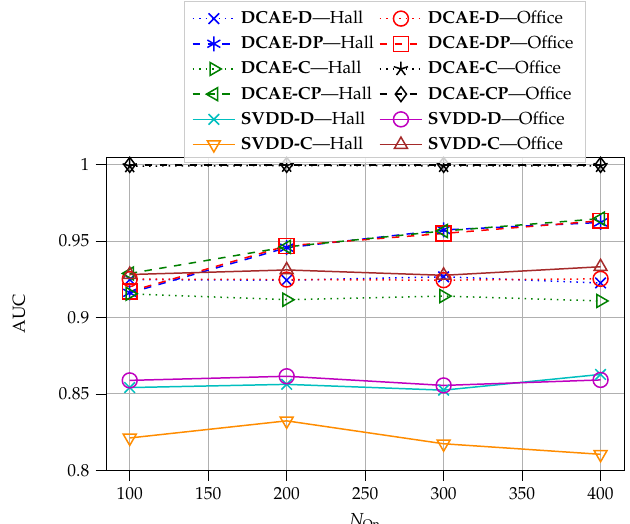
Figure 13. Impact of online batch size N On on the